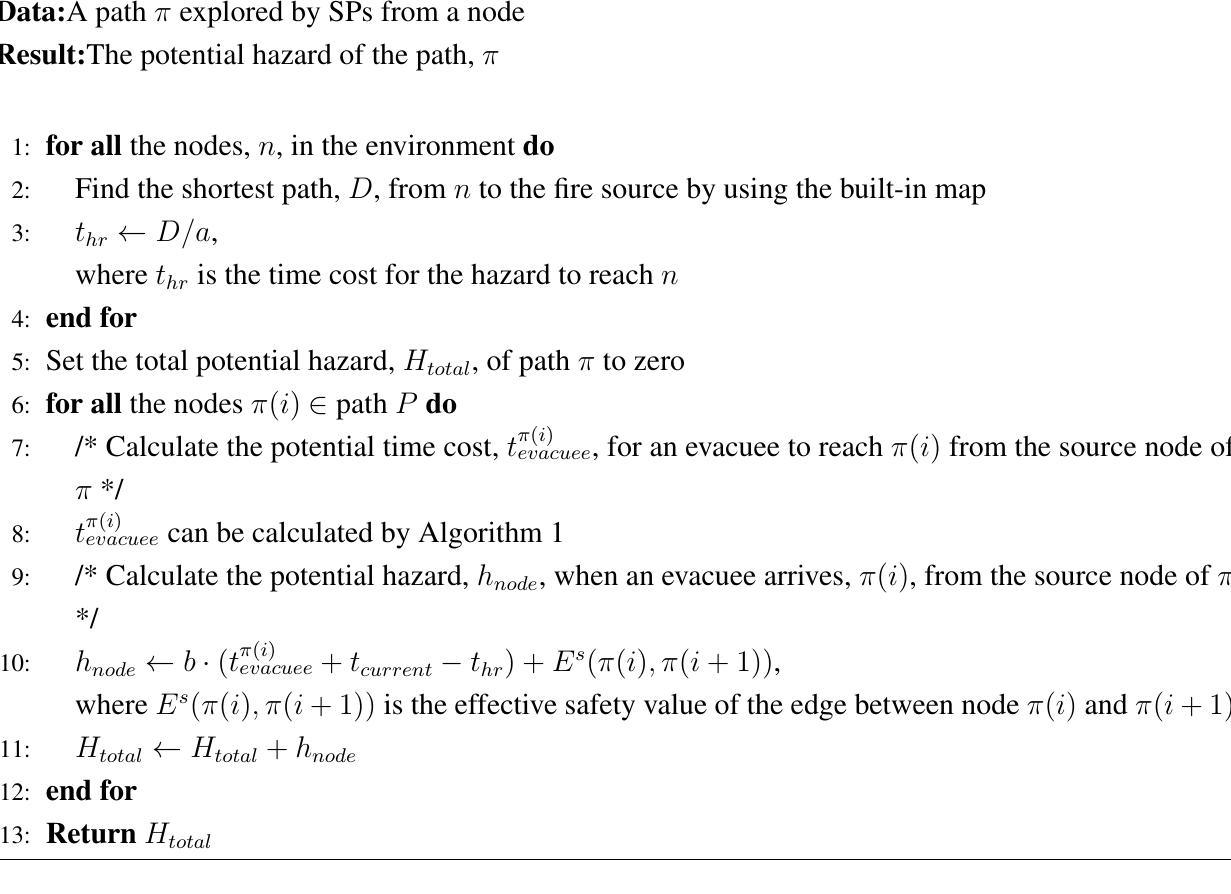
Algorithm 2 Predicting the potential hazard of a